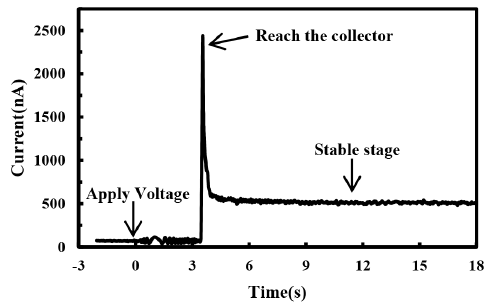
Figure 3. Time response of electrohydrodynamic direct-written current. The applied voltage, the distance between spinneret and collector, the solution concentration and the solution supply rate were 3 kV, 6 mm, 10%, and 100 µ L/h,